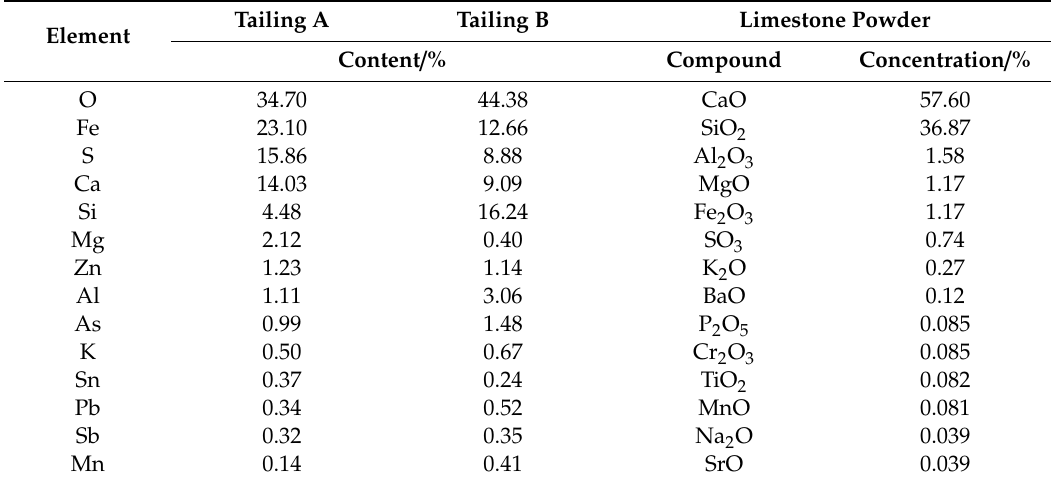
Table 1. Main mineral composition of tailings A and